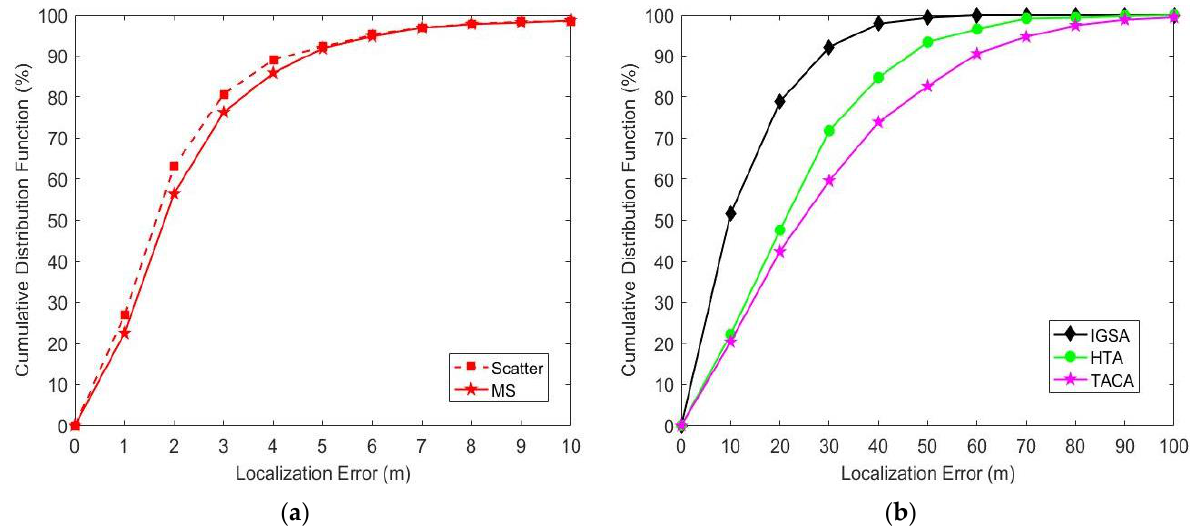
Figure 8. Localization error CDFs curve for DOS model. ( a ) The curve of proposed algorithm; ( b ) The curve of IGSA, HTA and NTA-CA.